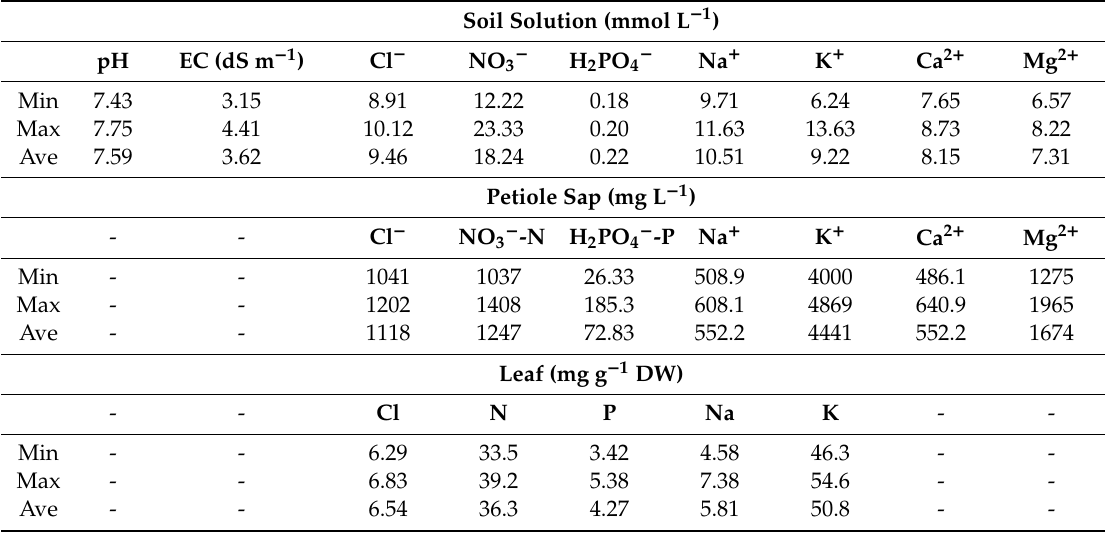
Table 2. Average, maximum, and minimum of soil solution values (pH and electrical conductivity (EC) (dS m − 1 )) and concentrations (Cl − , NO 3 − , H 2 PO 4 − , K + , Na + , Ca 2 + , and Mg 2 + (mmol L − 1 )), petiole